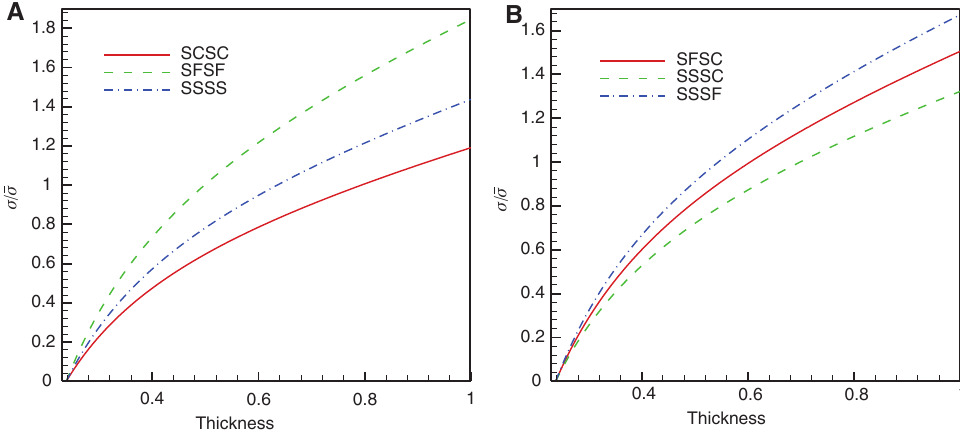
Figure 5: Comparison of non-dimensional stress through the thickness for different boundary conditions. (A) Symmetric boundary conditions. (B) Asymmetric boundary conditions.